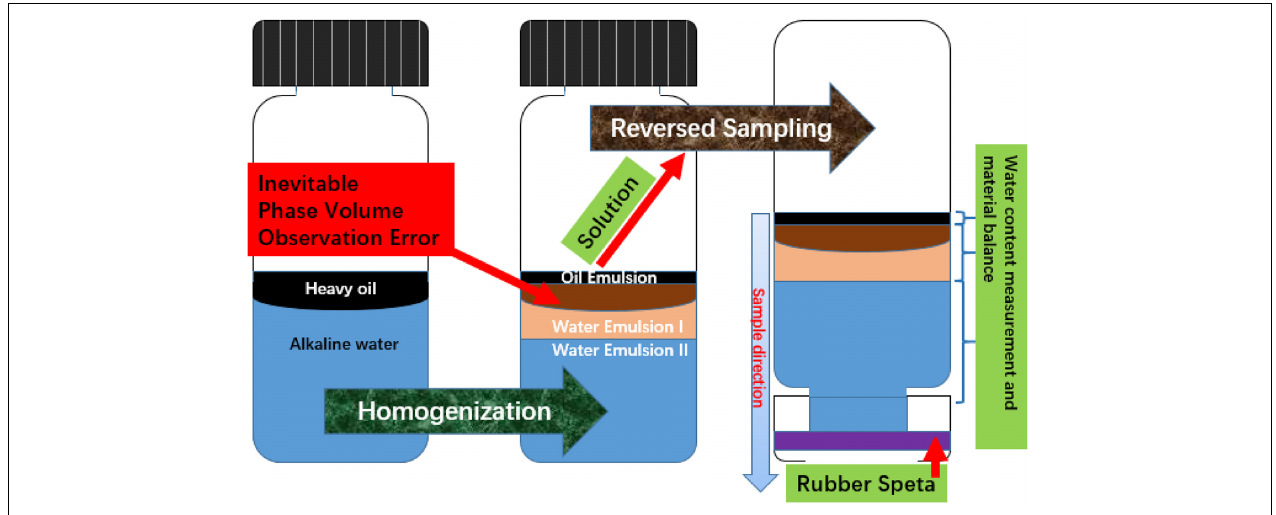
FIGURE 2 | Bottle test phase volume observation problem and solution of reversed sampling with open top cap and rubber speta.